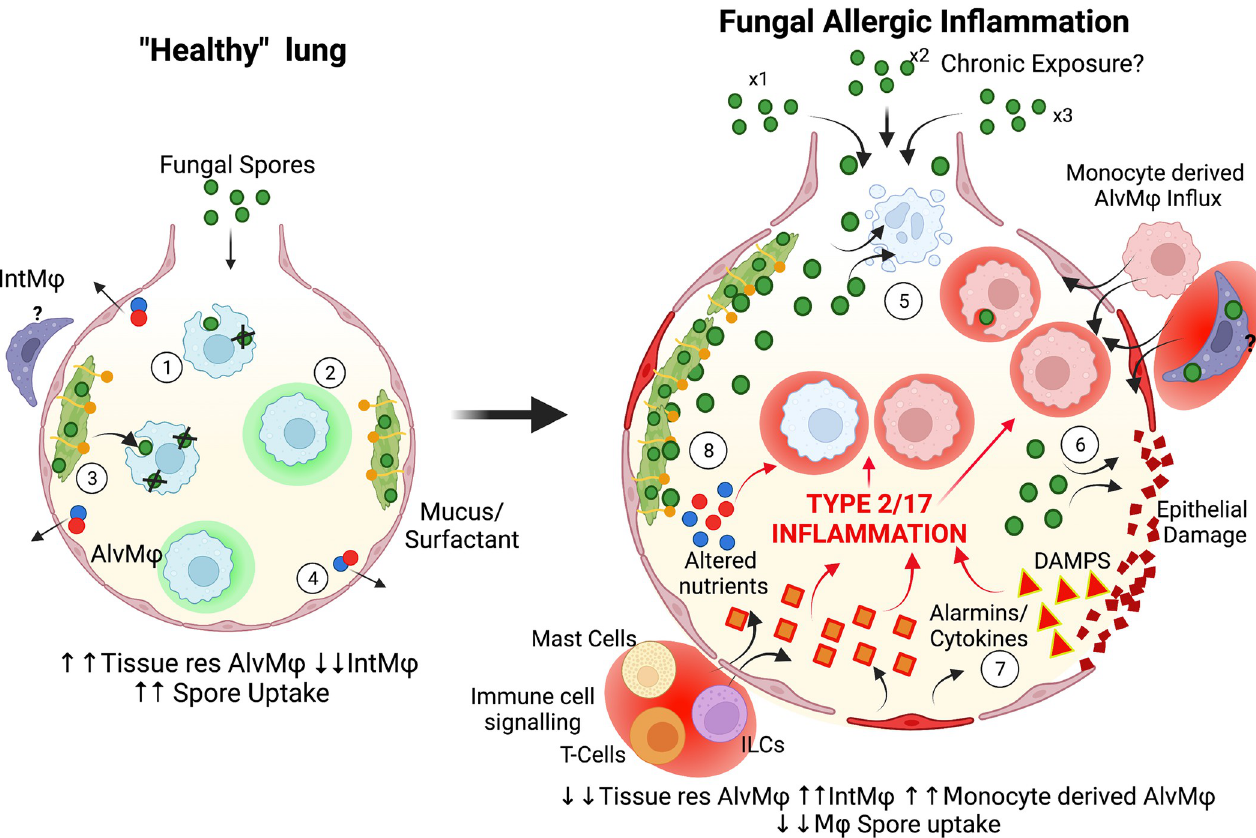
Fig 1. The influence of the lung environment and fungal spores on M F responses during allergic inflammation. In a “healthy lung environment” ( left ), ( 1 ) the majority of inhaled fungal spores are rapidly removed from the airways by AlvM F [43]. ( 2 ) Some AlvM F may not acquire spores and generate an anti- inflammatory environment [54]. ( 3 ) Spore uptake and killing, facilitated by the aid of components of the lung environment including epithelial cell secreted surfactants (SP-A, SP-D) and mucus (particularly the mucin glycoproteins, e.g., Muc5b) [45,159].( 4 ) Other features of the airway include a low nutrient airway environment (maintained by airway epithelial active transporters [170]) that maintain an immunoregulatory M F environment [144]. Upon allergic inflammation ( right ), ( 5 ) repeat spore exposure causes apoptosis or necrosis of resident AlvM F [183]. These are replaced by inflammatory IntM F s [26] or recruited monocytes [37,76].Both express altered inflammatory transcriptional and epigenetic profiles, leading to differential inflammatory responses upon subsequent spore exposure [71,73].( 6 ) Epithelial cell sensing of fungal material and/or damage to epithelial cell barrier (via fungal proteases), triggers the release of “alarmins” (e.g., TSLP, IL-33, IL-6, IL-22, and CCL2) [173–175]. ( 7 ) These epithelial signals can recruit and activate other immune cells such as mast cells, basophils and ILC2s inducing a type 2 cytokine environment directly impacting M F responses (potentially reducing spore killing) [135–138]. ( 8 ) Persistence of spores, disrupted epithelial barrier, immune cell infiltration (including CD4 + T cells) leads to a type 2 and 17 cytokine environment, alteration of airway nutrient concentrations and hyper secretion of mucus (including Muc5ac) and surfactants [151,158].These further promote pro-inflammatory M F antifungal responses, possibly sustaining allergic inflammation. Figures were created with BioRender.com. AlvM F , alveolar macrophage; CCL, chemokine ligand; DAMP, damage-associated molecular pattern; IL, interleukin; IntM F , interstitial macrophage; ILC, innate lymphoid cell; M F , macrophage; SP, surfactant protein; TSLP, thymic stromal